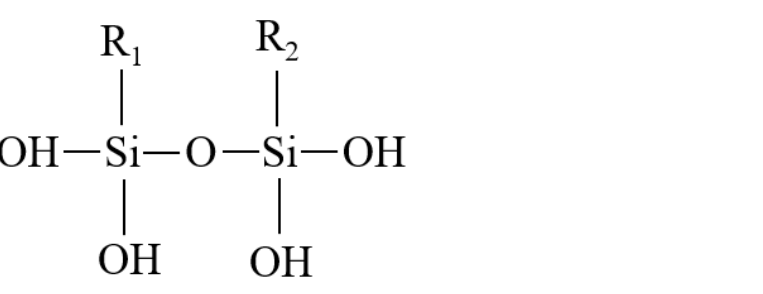
Figure 1. Molecule structure of organosilicon. (R 1 and R 2 stand for organic groups.) Table 1. Chemical composition of phosphogypsum and cement (wt. %).